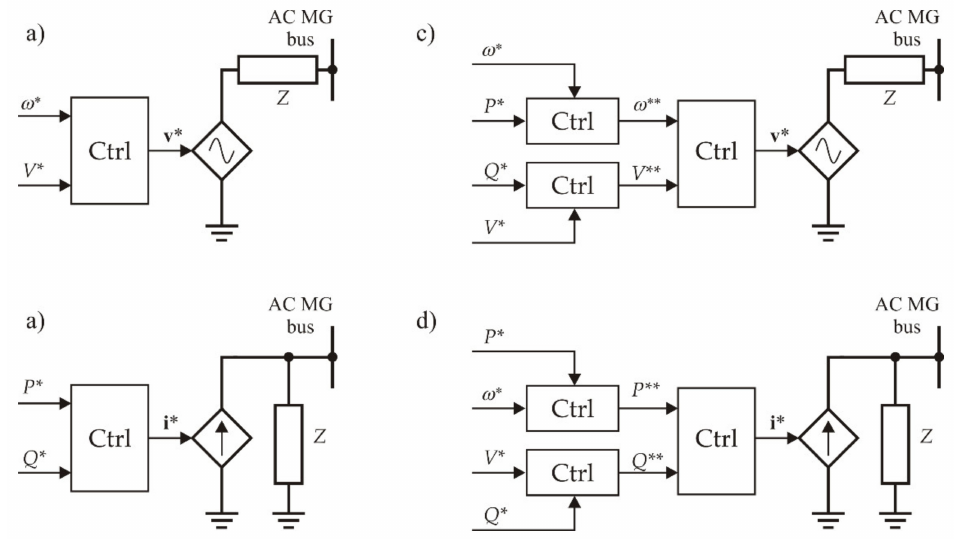
Figure 1. Elementary scheme for ( a ) grid forming; ( b ) grid feeding; ( c ) grid supporting acting as voltage source; ( d ) grid supporting acting as current source (adapted from